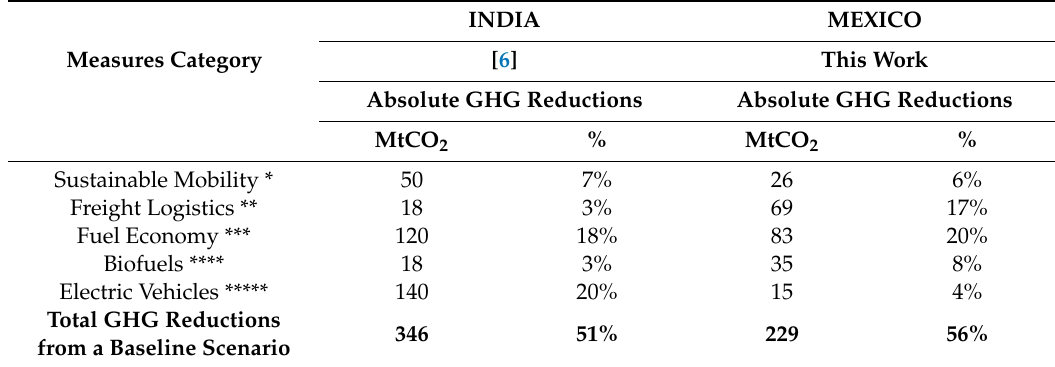
Table 11. Comparison of mitigation results of similar transport sector´s Low Carbon Scenarios in 2035 from India [6] and Mexico (this work) in absolute and relative values relative to a baseline scenario. INDIA MEXICO Measures Category [6] This Work Absolute GHG Reductions Absolute GHG Reductions MtCO 2 % MtCO 2 % Sustainable Mobility * 50 7% 26